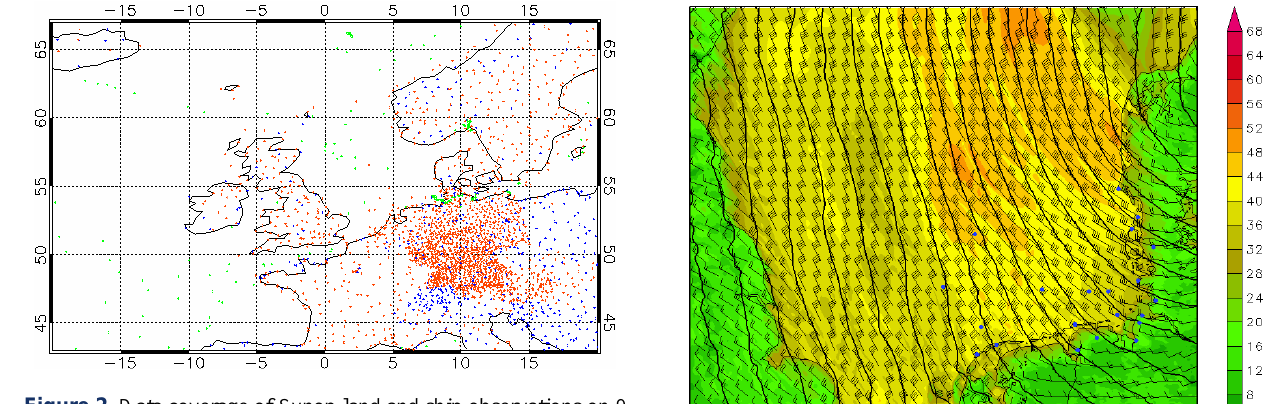
Figure 2. Data coverage of Synop land and ship observations on 9 November 2007. The blue dots show the manned land stations, the red dots the automatic land stations and the green dots the ships.